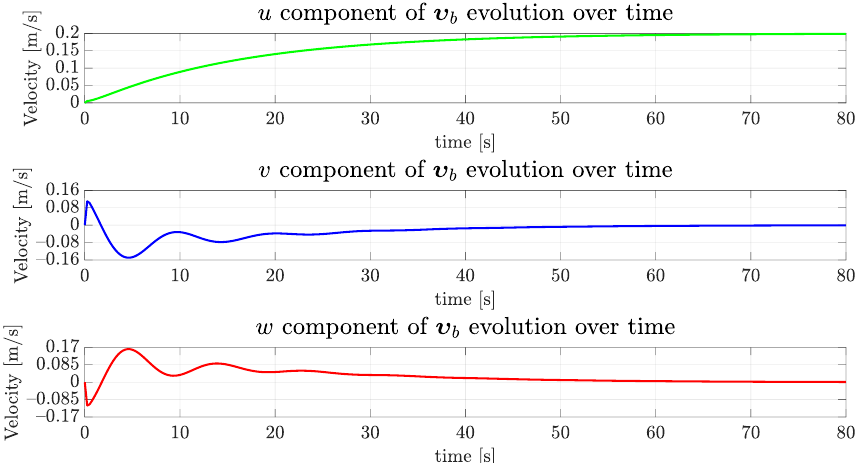
Figure 17. The evolution of the components of the simulated vehicle linear velocity over time for the straight